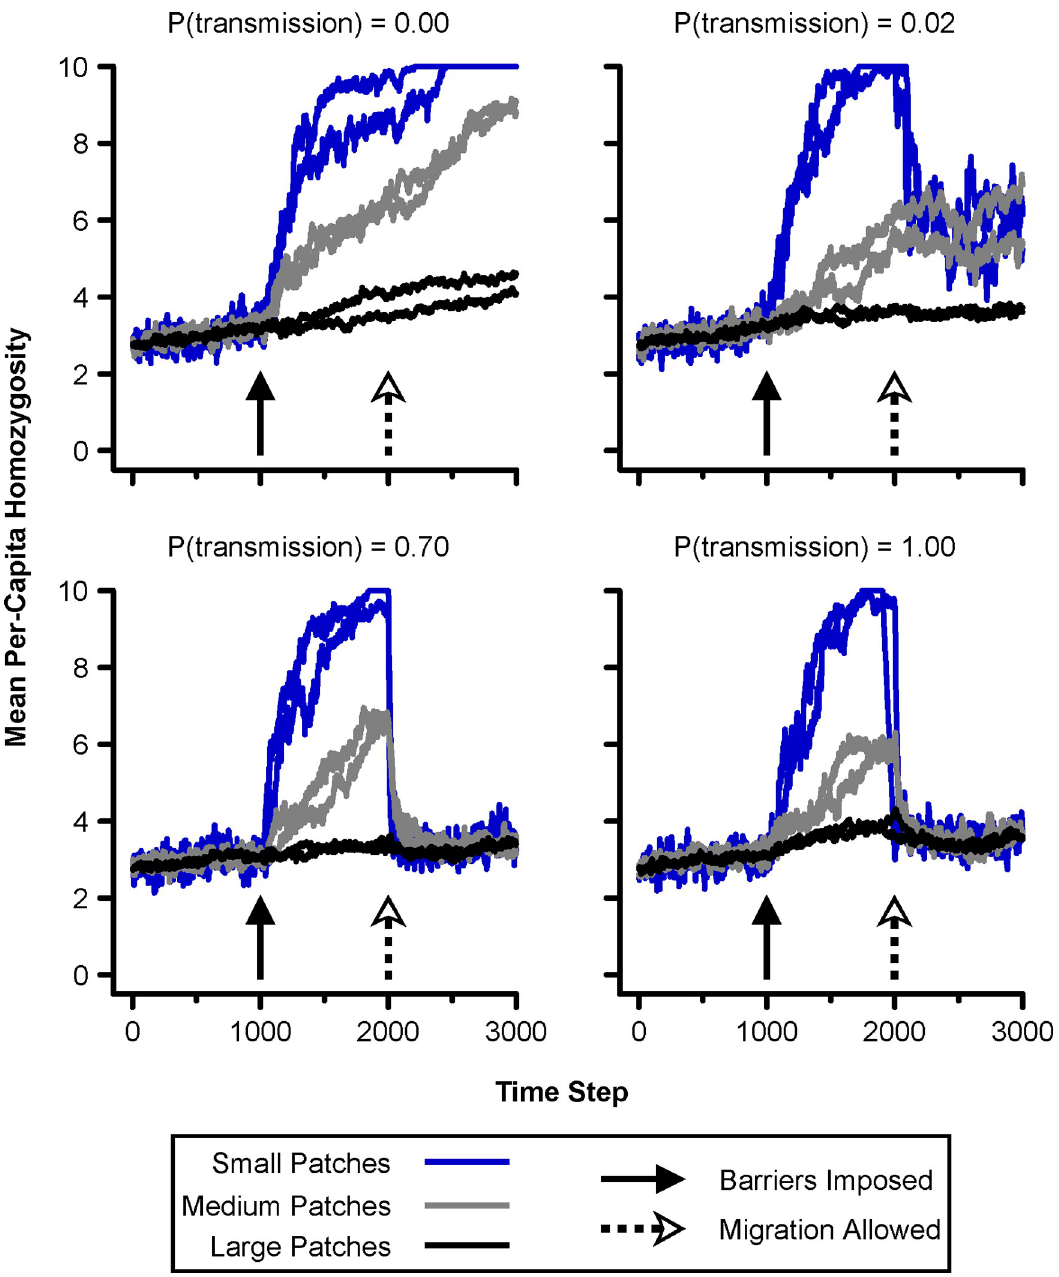
Fig 5. Per-capita homozygosity across simulation time steps spanning the Continuous , Isolated Patches , and Semi-Connected landscape epochs, displayed by patch size. Our simulated low and high barrier crossing probabilities corresponded to P (transmission) values of 0.02 and 0.70, respectively. Six lines per plot result from two small, two medium, and two large